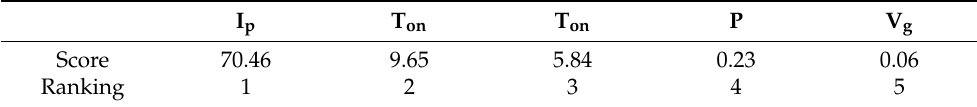
Table 7. Importance of each process